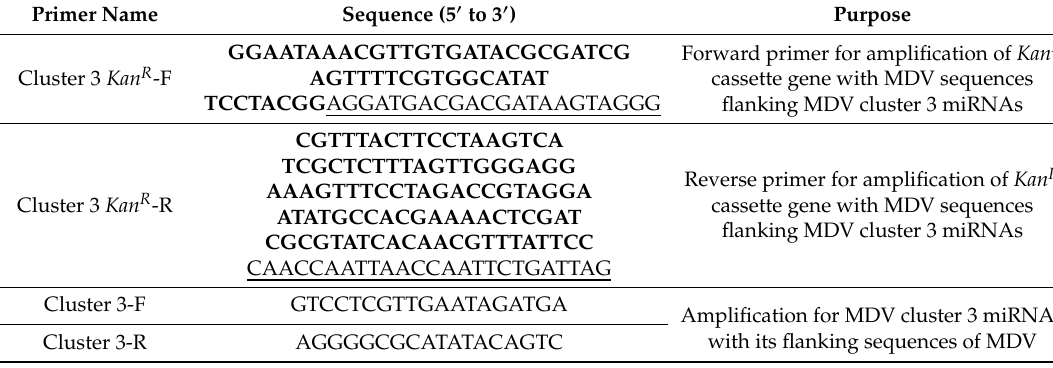
Table 1. List of primers used in the construction of cluster 3 microRNA (miRNA) deletion